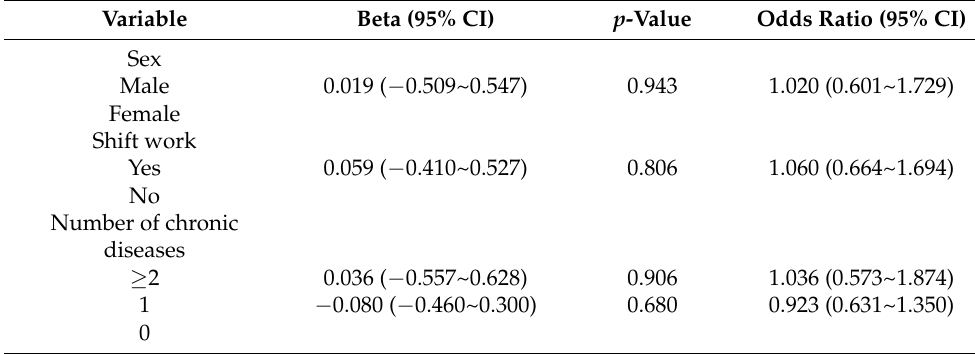
Table 3. Risk factors for metabolic syndrome in hospital